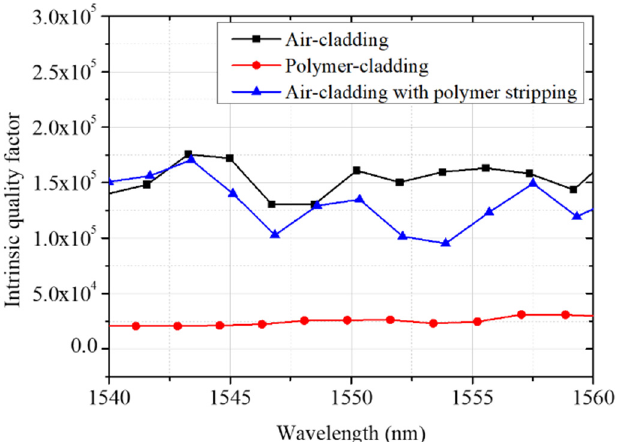
Figure 11. The distribution of the intrinsic quality factor Q i for air-cladded, SU-8 polymer-cladded, and air-cladded resonators with polymer stripping.